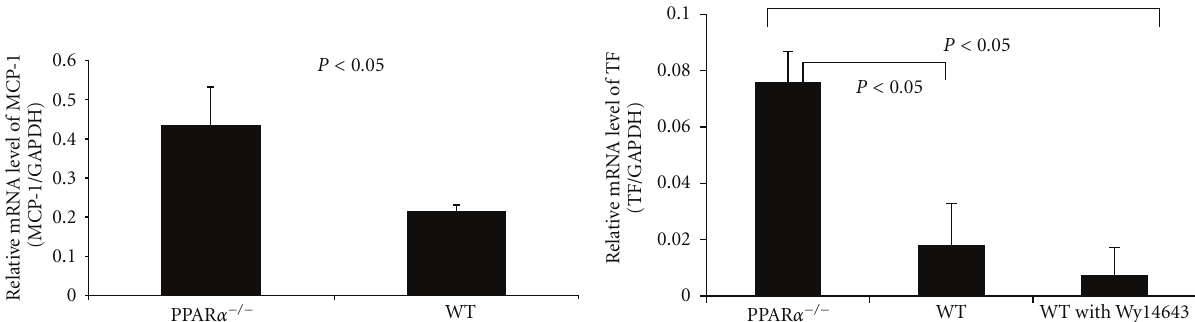
Figure 4: The e ff ects of PPAR α and PPAR α activation on MCP-1 and TF expression after arterial injury determined by real-time PCR. (a) MCP-1 mRNA level was much higher in the PPAR α knockout group when compared to WT group; (b) TF mRNA level was much higher in the PPAR α knockout group when compared to WT group and WT group treated with Wy14643. PPAR α activation further decreased TF expression when compared to untreated WT group but did not reach statistic significance.